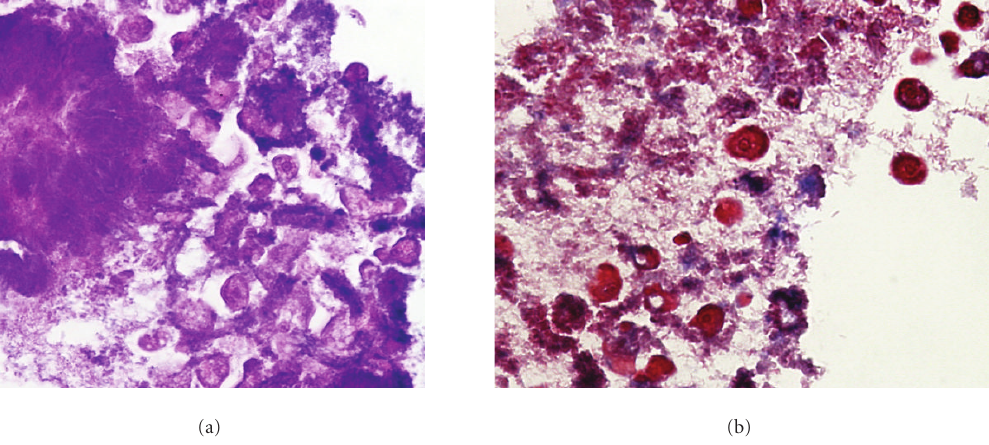
Figure 1: Entamoeba gingivalis. (a) Acute osteomyelitis with mixed flora, including branching rods and cocci, colonies of filamentous bacteria consistent with Actinomyces , and numerous organisms morphologically consistent with Entamoeba gingivalis ; (b) Trichrome staining highlights the forms morphologically consistent with Entamoeba